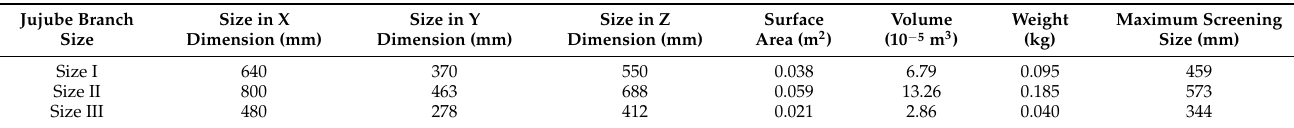
Table 1. Sizes and parameters of jujube